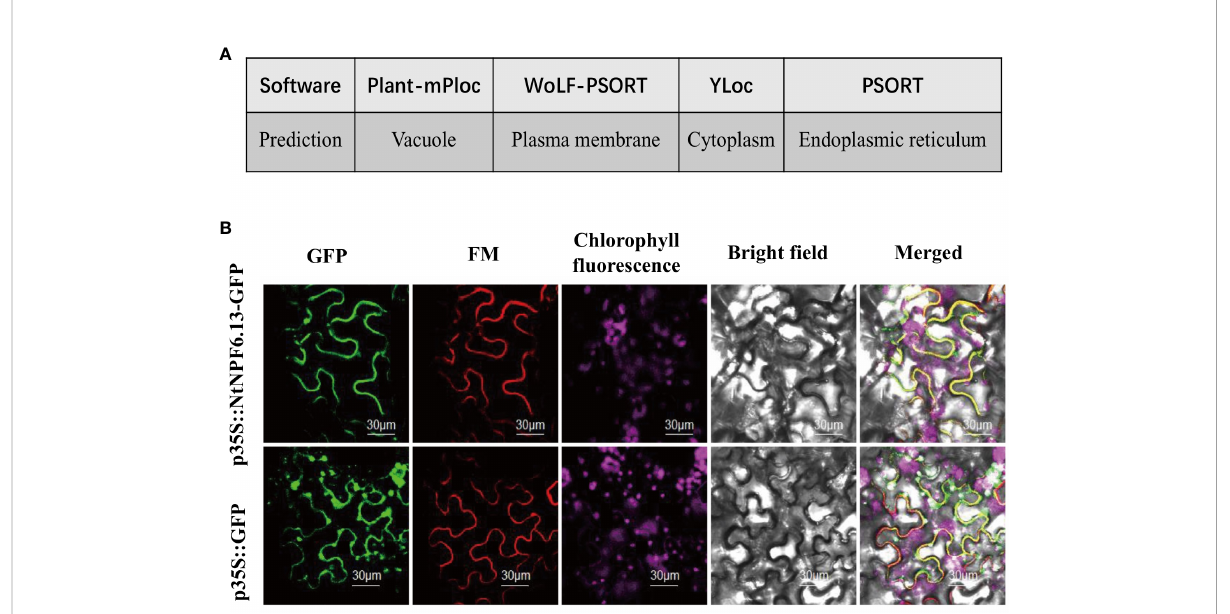
FIGURE 6 Subcellular localization of NtNPF6.13. (A) Localization predicted by different online tools. (B) Co-localization of NtNPF6.13-GFP with the plasma membrane marker FM in N.benthamiana leaves. Confocal images were captured the day after agroin fi ltration. NtNPF6.13-GFP represents the gene and GFP represents the control with an empty